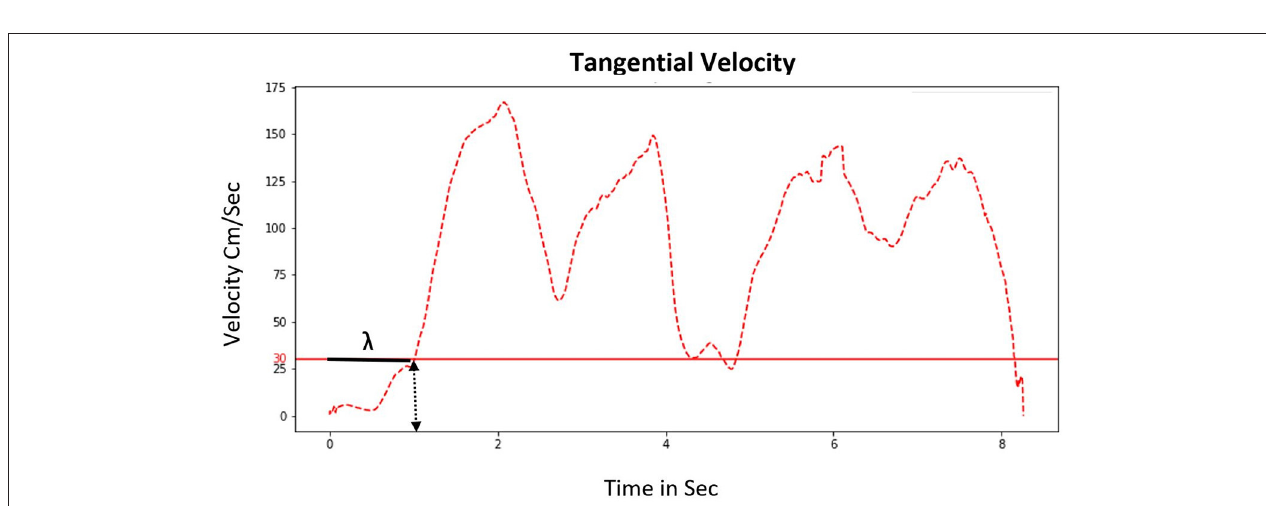
FIGURE 5 | Representation of the computing tangential velocity and latency (Lambda, λ ) of one participant during a trail in the Learning phase. In the X-axis, the zero corresponds to the moment when the house was lit on the ground indicating “GO” signal. The time of real departure of the subject was computed when the tangential velocity was above the threshold of 30 cm/sec. The “ λ ” is the delay between the “GO” signal and the velocity exceeding the